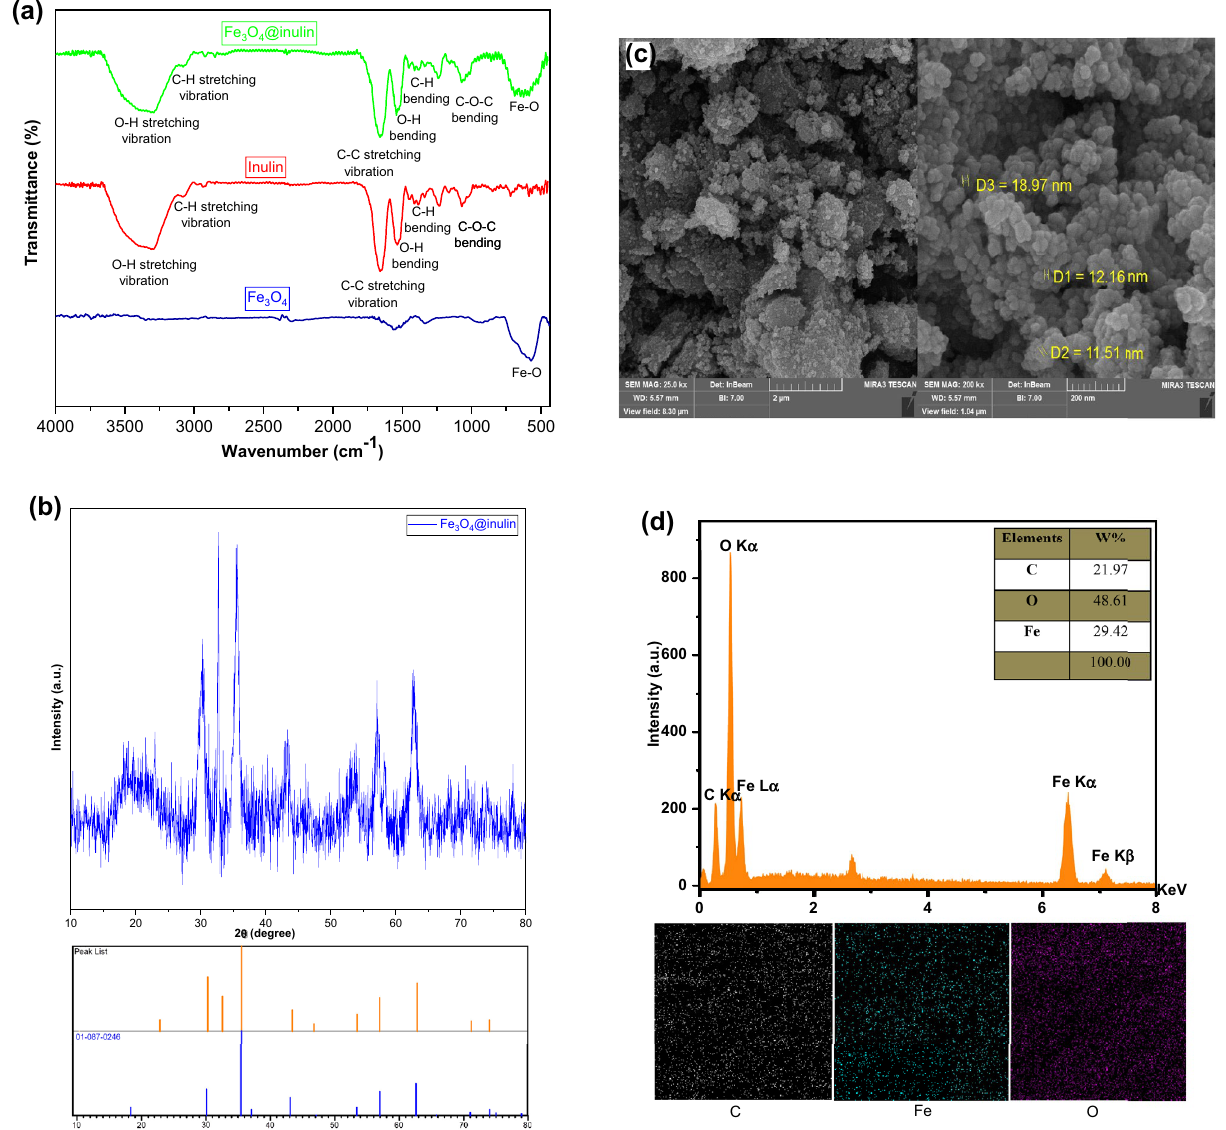
Figure 2. ( a ) FTIR spectra of Fe 3 O 4 , inulin, and Fe 3 O 4 @inulin; ( b ) XRD pattern of the prepared Fe 3 O 4 @inulin nanocomposite; ( c ) SEM images and (d) EDX results of the synthesized Fe 3 O 4 @inulin bio-nano